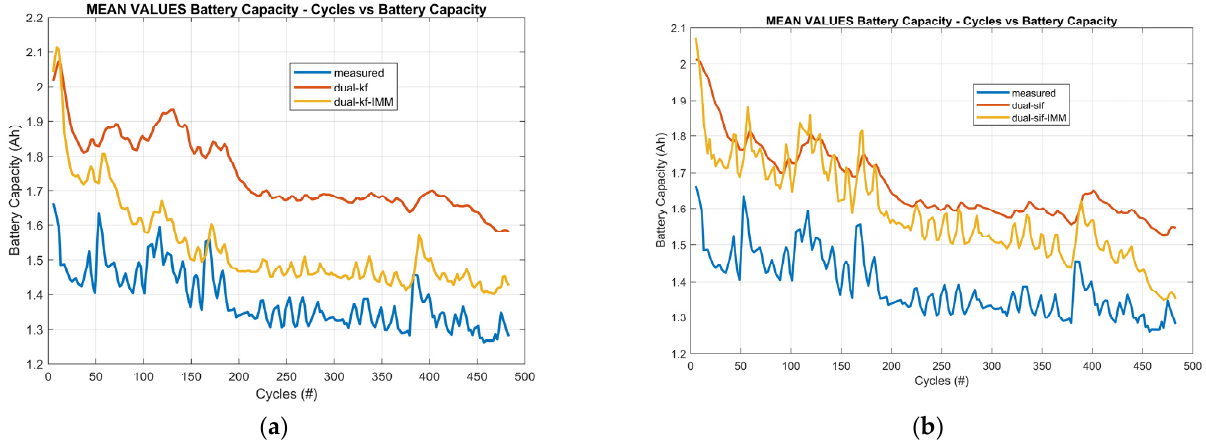
Figure 18. ( a ) Dual-KF and dual-KF-IMM internal resistance estimates. ( b ) Dual-SIF and dual-SIF- IMM internal resistance estimates.